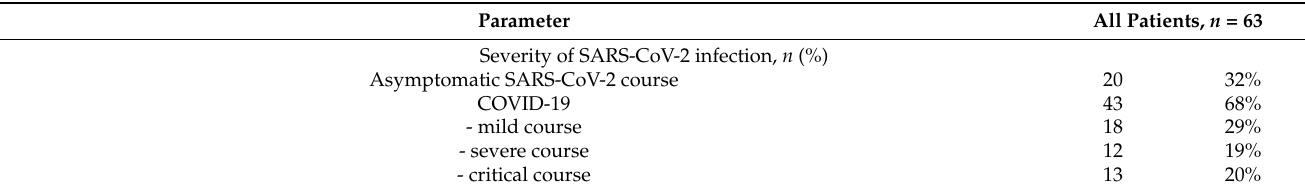
Table 3. Outcomes of SARS-CoV-2 infection in 63 cancer patients. N , number; IMC, intermediate care; ICU, intensive care unit; PD, progressive